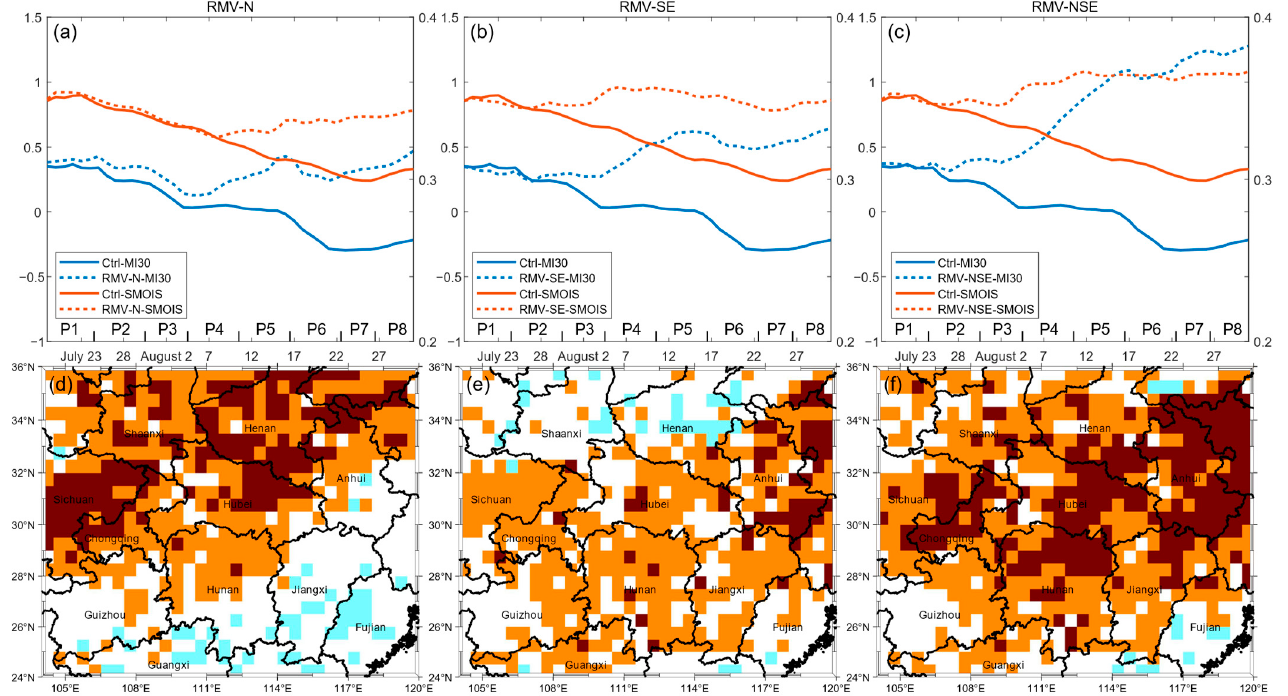
Figure 12. ( a – c ) Area average soil moisture (SMOIS) and MI30 comparison between the control run (blue line for MI30, yellow line for SMOIS; m 3 m − 3 ) and the sensitivity runs (red line for MI30, purple line for SMOIS; m 3 m − 3 ). ( d – f ) The decline in drought level in sensitivity runs compared with the control run (shading: orange block means one-level decline, brown block means two-level decline, and blue box means one-level increase).